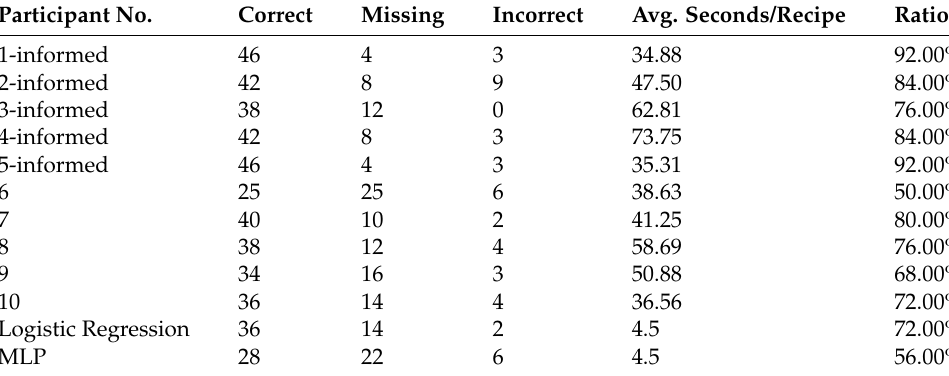
Table 4. User study results, showing the correct, missing and incorrectly labelled allergens out of a total amount of 50 allergens spread across recipes. The ratio shows correctly labelled allergens to the total amount of